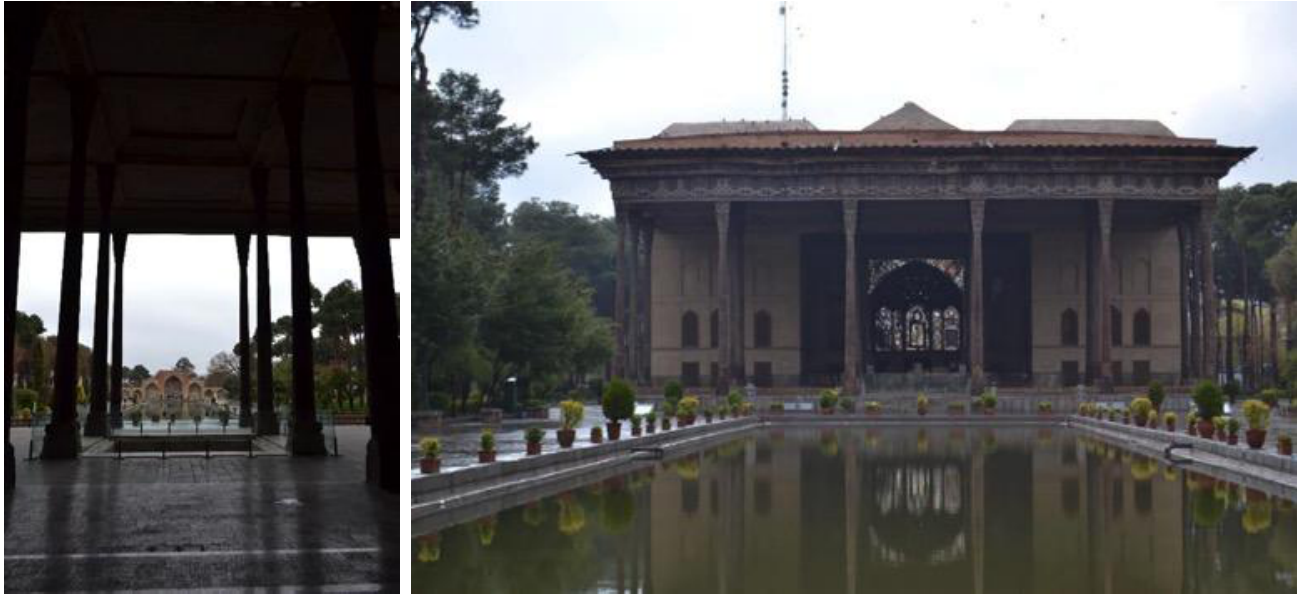
Figure 13. Openness of landscape in Chehel-Sotun garden, Esfahan. Photos by: Alan Cordova from